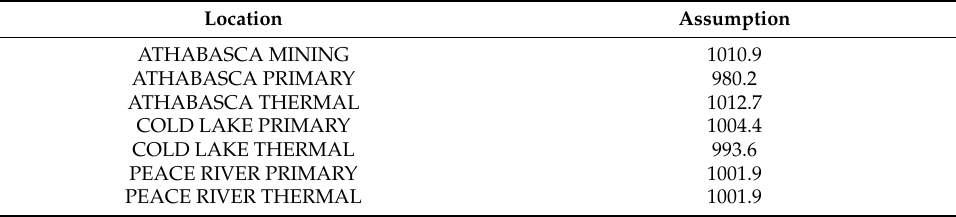
Table A1. Assumed bitumen density (absolute density at 15 ◦ C, kg/m 3